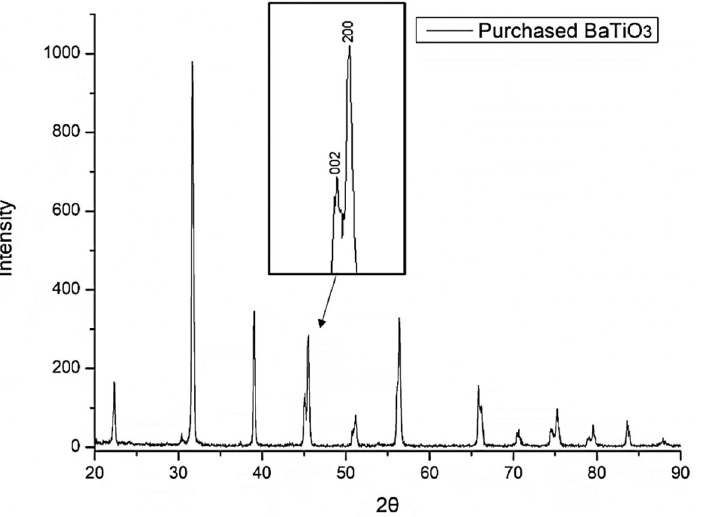
Figure 6. X-ray diffraction patterns of purchased BaTiO 3 powders. The inset shows the split peaks of (002) and (200) indicating the tetragonal